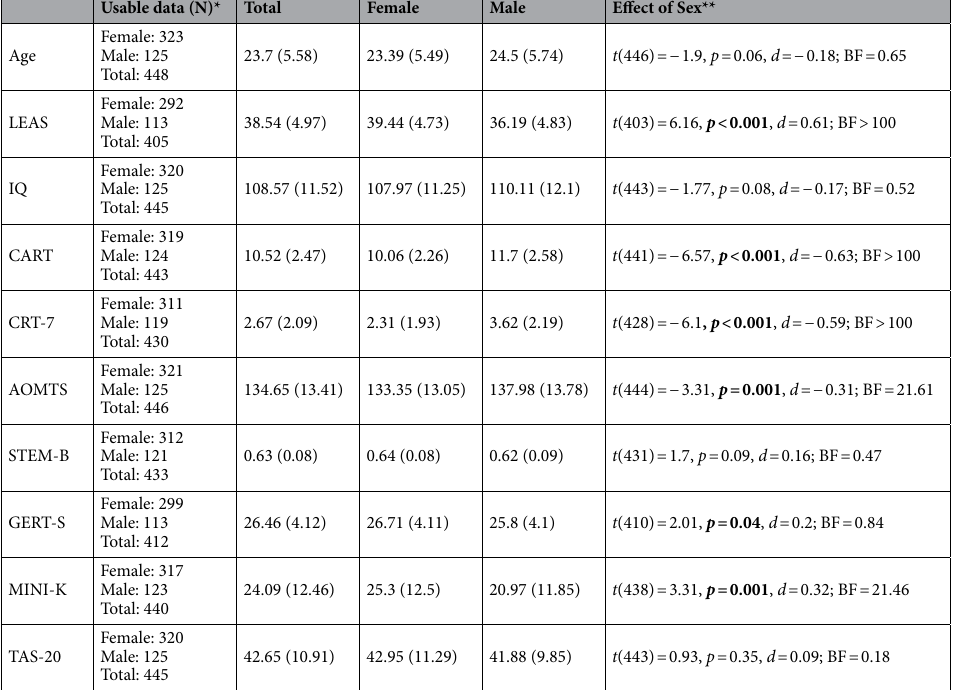
Table 1. Summary statistics (mean and SD) for study measures by sex. *Not all data were available from all participants. Outlier values greater than three standard deviations from the mean were also removed. We therefore report final available Ns for each measure. ** Significant sex differences at p < .05 are bolded for